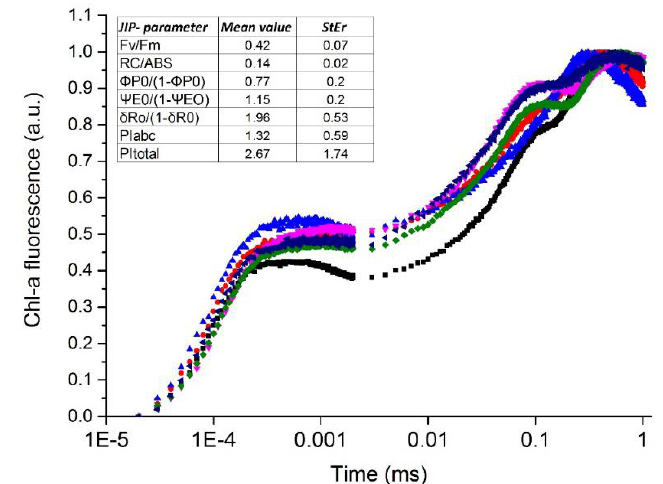
Figure 2. Rapid chlorophyll fluorescence induction curves (n = 6 replicates are shown in different colors) of bloom biomass and mean values and Standard Error (±) of the most important JIP-test parameters. F 0 : Minimal fluorescence intensity when all PSII reaction centers (RCs) are open; F m : Maximal fluorescence intensity when all PSII RCs are closed; F v /F m : Maximum quantum yield of PSII; RC / ABS: Density of RCs; Φ P0 = TR o / ABS: Maximum quantum yield for primary photochemistry (at t = 0); ΨΕ0 = ET 0 /TR 0 : Probability that a trapped exciton moves an electron into the electron transport chain beyond QA (at t = 0); δ R0 = RE 0 / ET 0 : Probability with which an electron from the intersystem electron carriers is transferred to reduce end electron acceptors at the PSI acceptor side (RE); PI abc : Performance index for energy conservation from photons absorbed by PSII antenna, to the reduction of QB; PI total : Performance index for energy conservation from photons absorbed by PSII antenna, until the reduction of PSI acceptors.